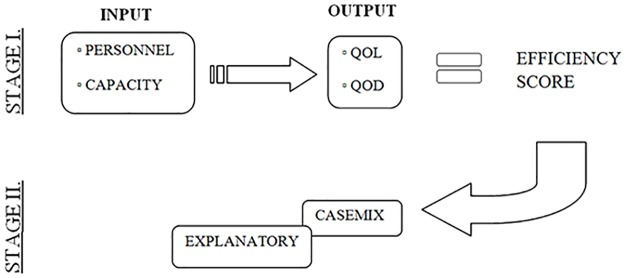
Production function.